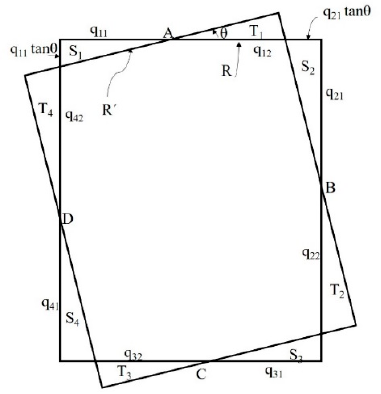
' R (cid:48) by edge by edge rotation. Figure 10. Formation of rectangle R